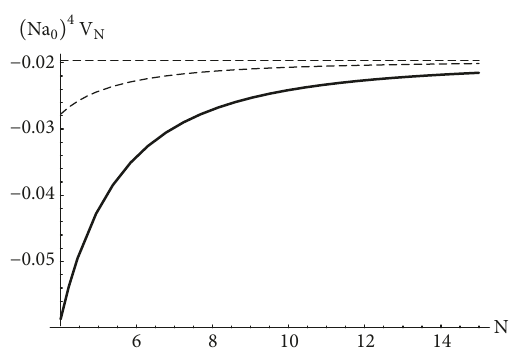
Figure 8: The numerical value of (𝑁𝑎 0 ) 4 𝑉 푁 for the model in this subsection as a function of 𝑁 . The dotted lines indicate (1/4)(𝑁𝑎 ) 4 𝑉 𝑉 0 푁 , where 푁 is the vacuum energy density in the real scalar theory whose mass matrix is Δ(𝐶 푁 )/𝑎 2 0 , and the constant −3𝜁(5)/16𝜋 2